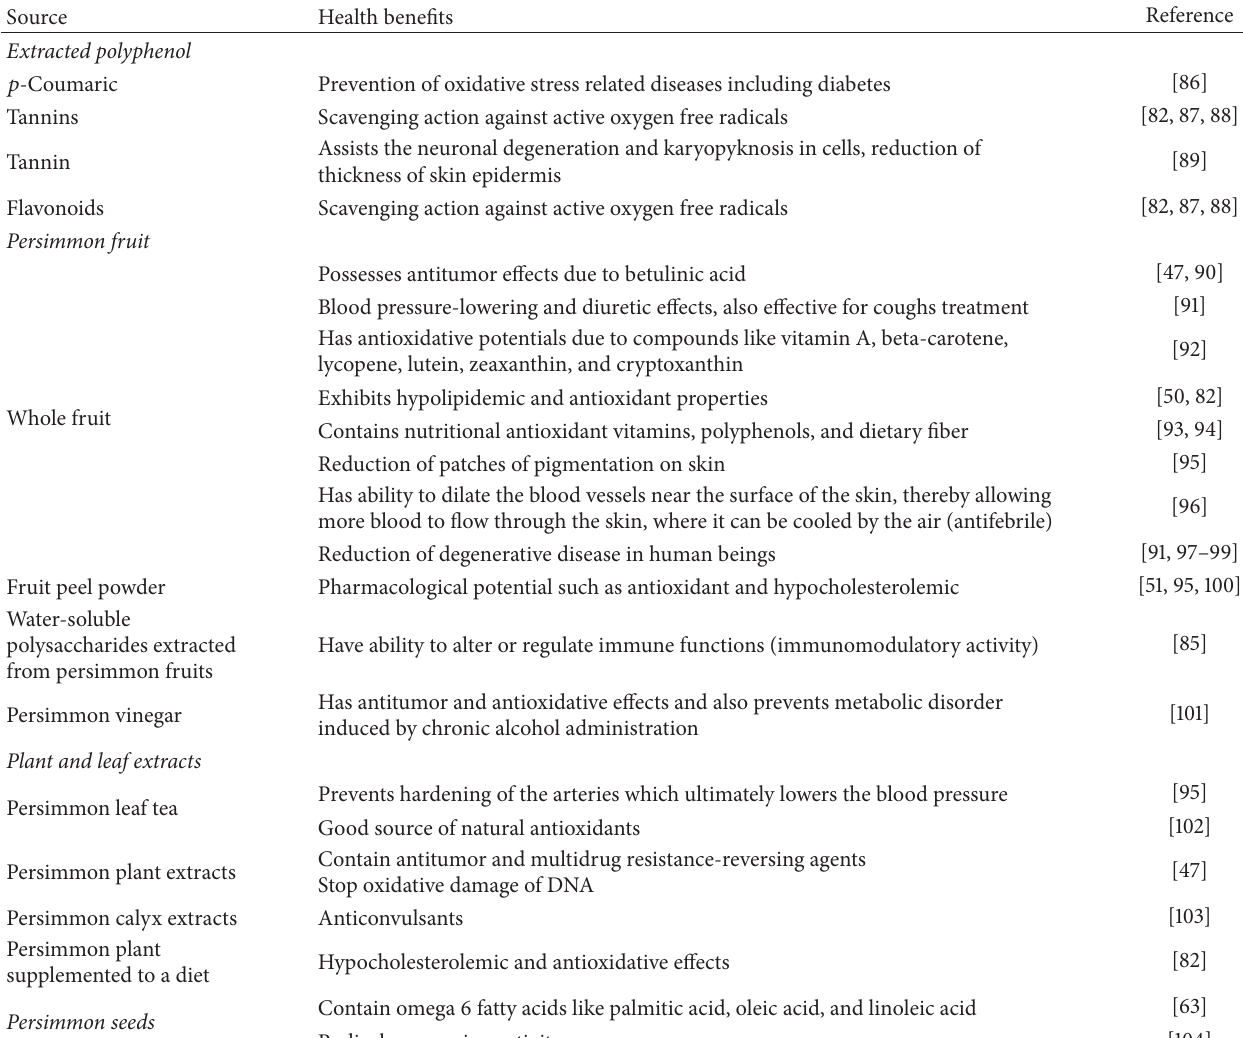
Table 2: Various bioactive compounds present in persimmon and their functional